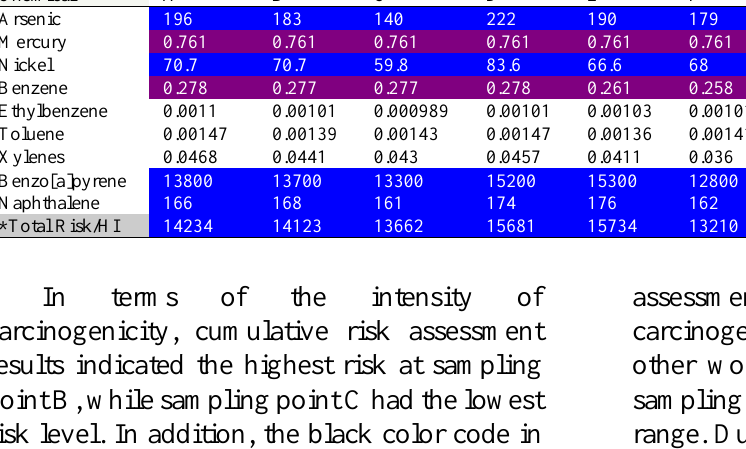
Table 14. Unit and cumulative risk of studied non-carcinogenic pollutants